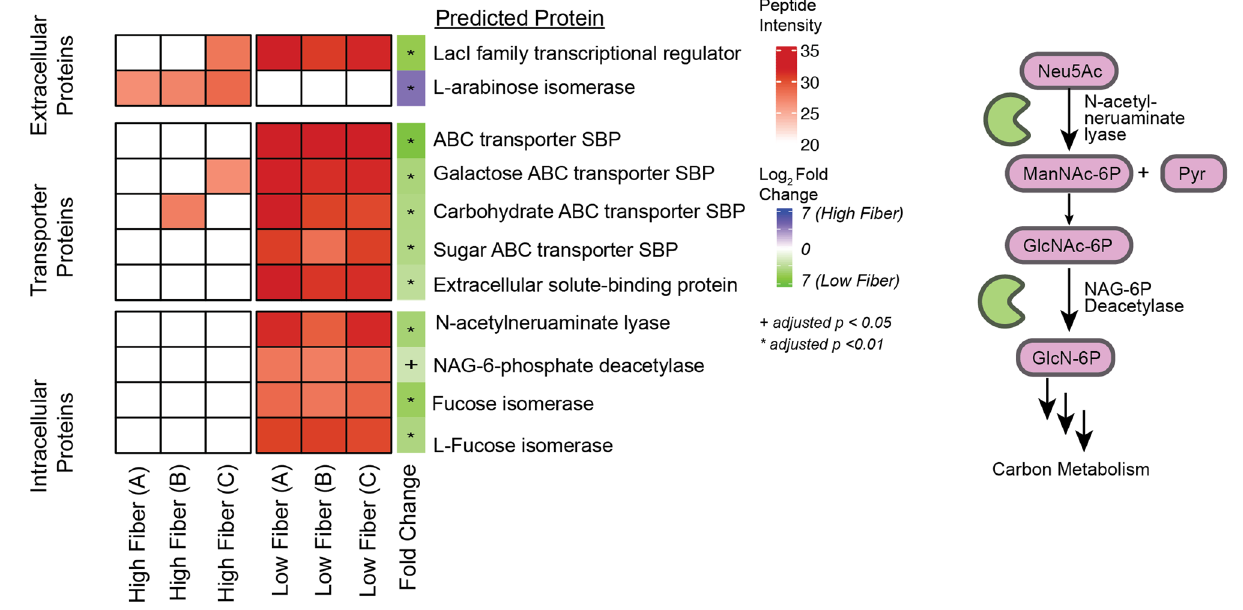
Fig. 4 “ M. intestinale ” proteins involved in carbohydrate uptake and sialic acid (Neu5Ac) breakdown are more active under LF conditions. a 10 of 11 identi fi ed “ M. intestinale ” proteins were signi fi cantly enriched under LF conditions ( q value < 0.05), while a predicted L-arabinose isomerase was only detected under HF conditions. The log 2 -transformed sum of unique peptide intensities for proteins is shown in red, while white cells indicate the protein was not detected in that sample group. Imputed log 2 fold change is shown on the right (blue: enriched in HF conditions, green: enriched in LF conditions). b Two key enzymes in Neu5Ac degradation — an N-acetylneuraminate lyase and an N-acetylglucosamine-6P-deacetylase — were more active under LF conditions, indicating “ M. intestinale ” actively catabolizes Neu5Ac in the absence of soluble dietary fi